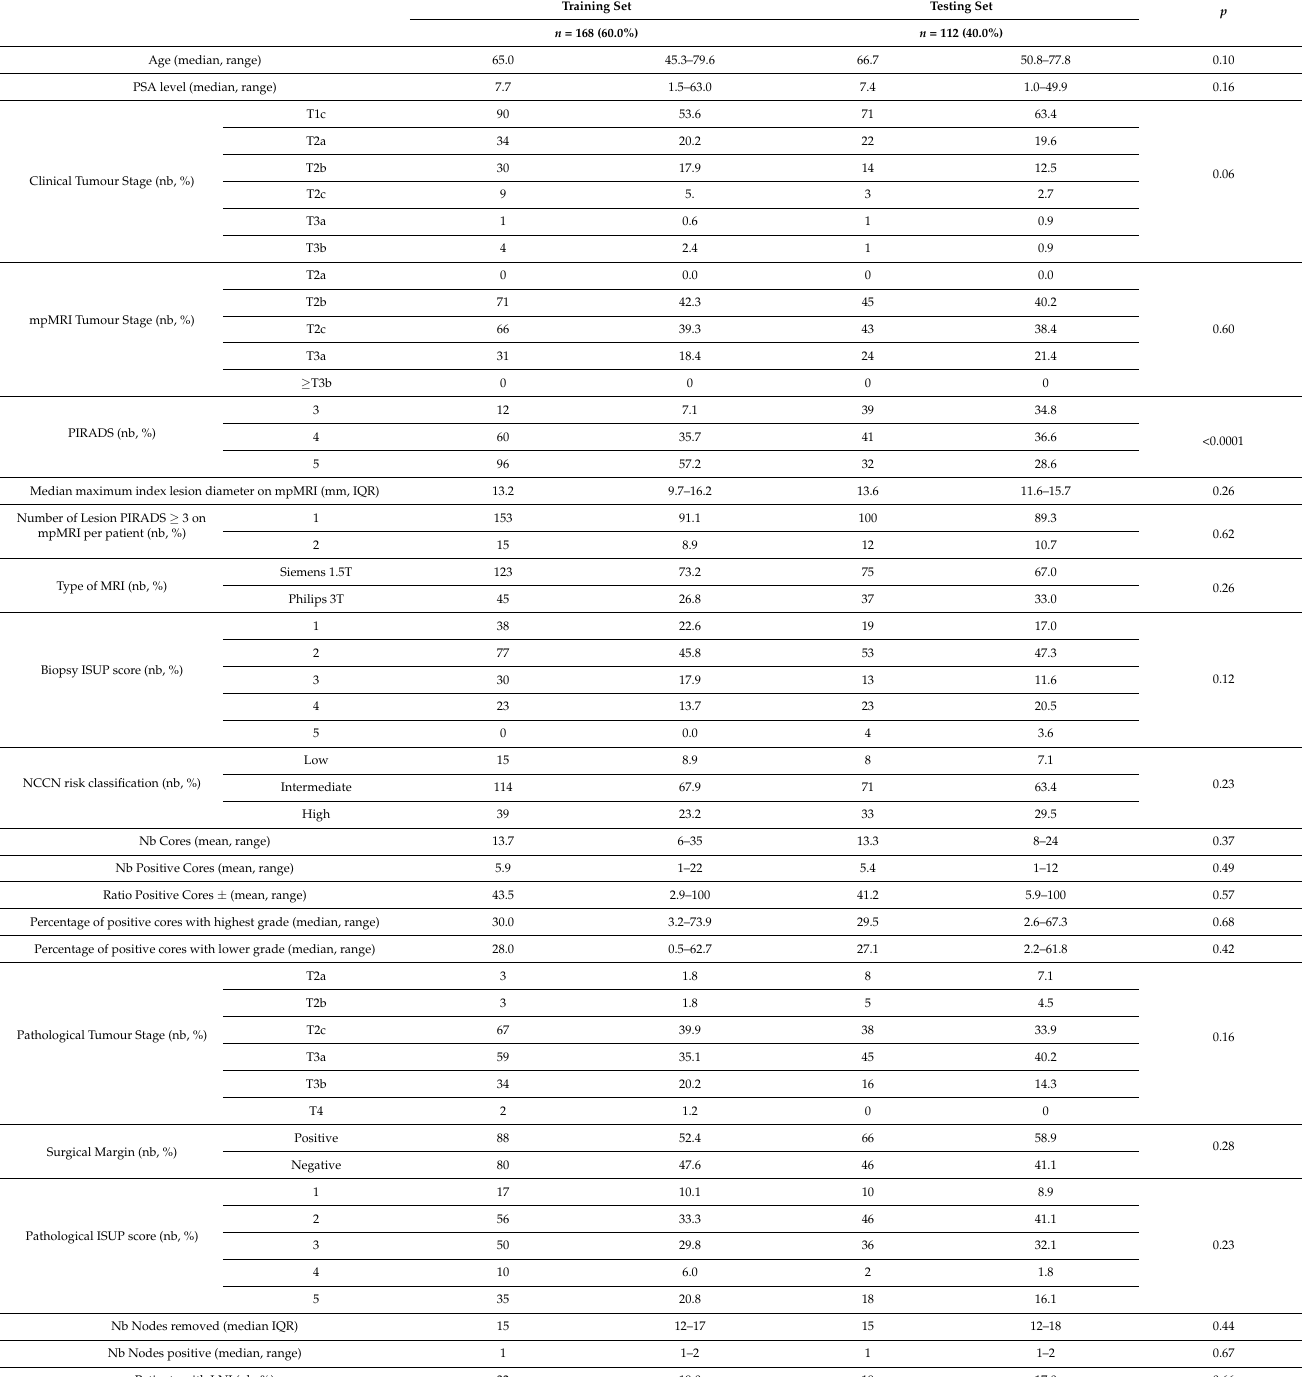
except for the PIRADS classification. Main patients’ characteristics are summarized in Table 1. A flow-chart is proposed as Supplementary Figure S1. Table 1. Patient and tumour characteristics in the training and testing